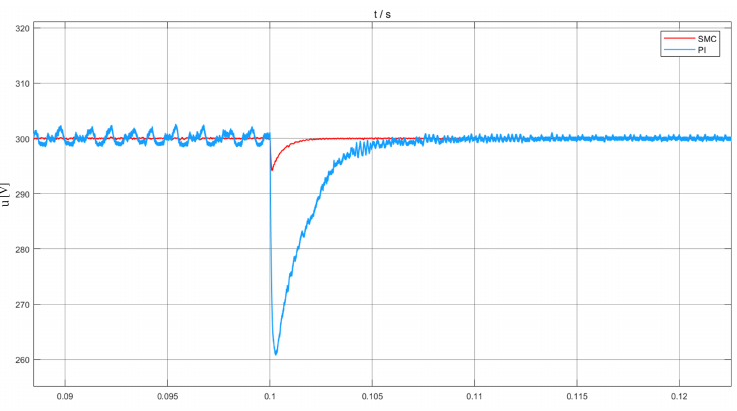
Figure 12. Output voltage response curve after a sudden change.